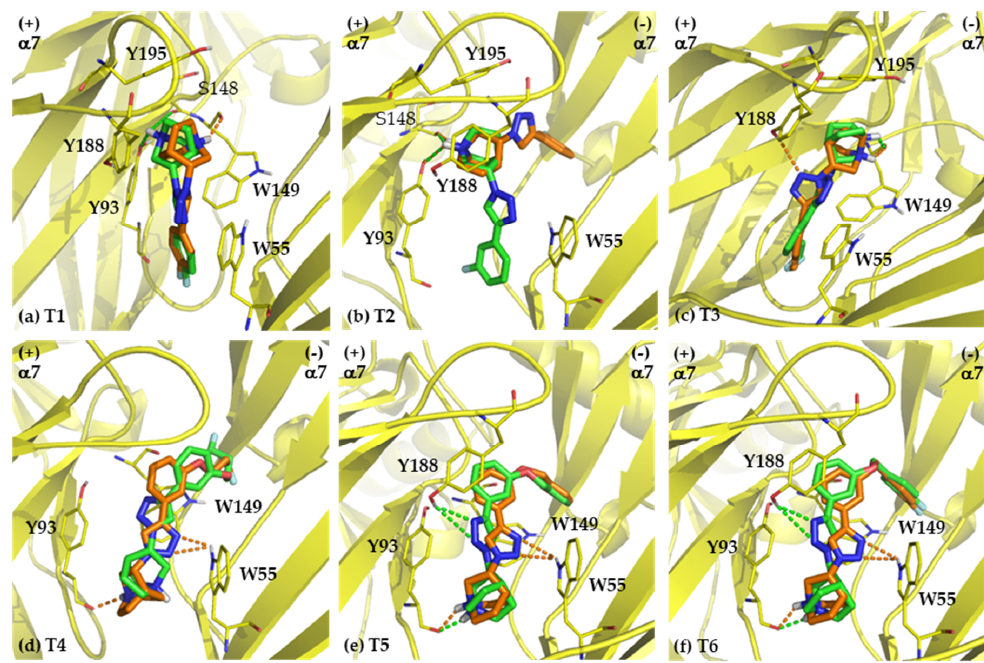
Figure 5. The docking poses to the α7 nAChR of the ( R )-enantiomers (orange) and the ( S )-enantiomers (green) of T1-T6 ( a – f ). The amino acid residues forming hydrogen bond, cation-π, and π-π interactions are shown. The polar hydrogen atoms of the interacting amino acid side chains are displayed to identify hydrogen bond donors and acceptors. The conserved residues are shown in bold. Yellow, α7 nAChR; red, oxygen; blue, nitrogen; orange dashed lines, hydrogen bond interaction with ( R )-enantiomers; green dashed lines, hydrogen bond interaction with ( S )-enantiomers.